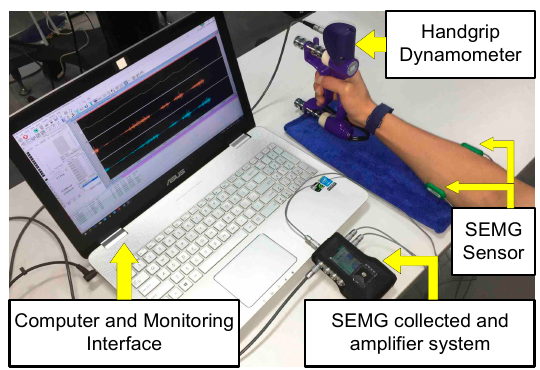
Figure 1. Experimental setup. SEMG: surface electromyogram.